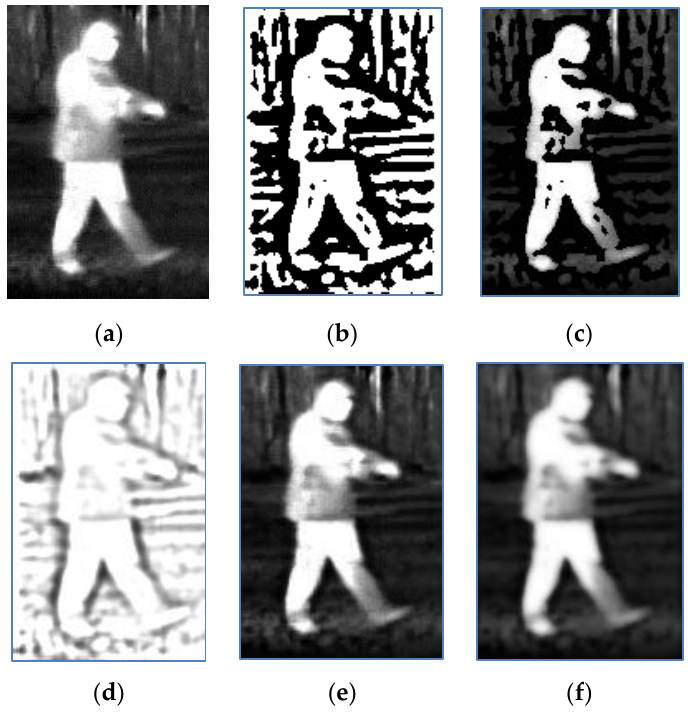
Figure 2. ( a ) Original image; ( b ) One-bit image; ( c ) Original image masked with ( b ); ( d ) Soft mark image; ( e ) Original image marked with ( d ); ( f ) Smoothed image marked with ( d